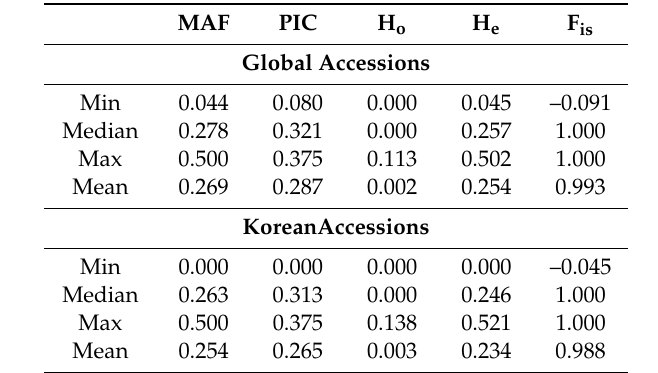
Table 1. The genetic diversity statistics of global (376 accessions) and Korean (229 accessions) cowpea accessions based on 35,116 single-nucleotide polymorphisms